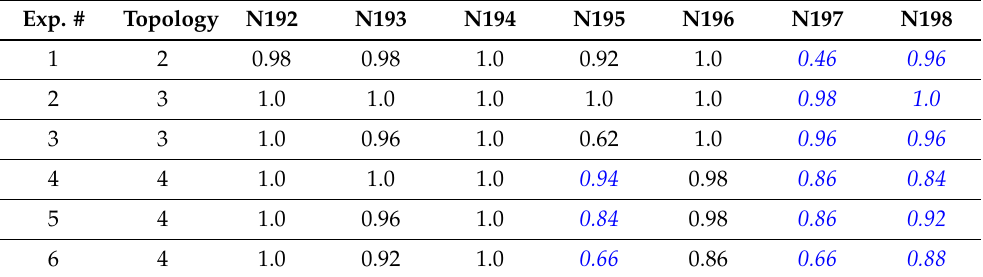
Table 1. End-to-end packet delivery rates from six consecutive experiments on the Heslington East lake (blue italic text indicates dual-hop